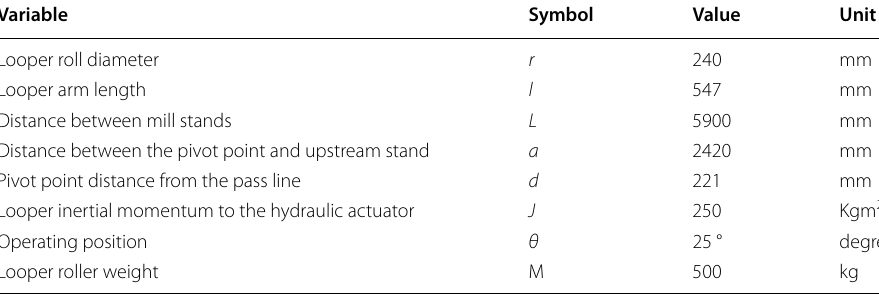
Table 3 The looper geometry main data Variable Symbol Value Unit Looper roll diameter r 240 mm Looper arm length